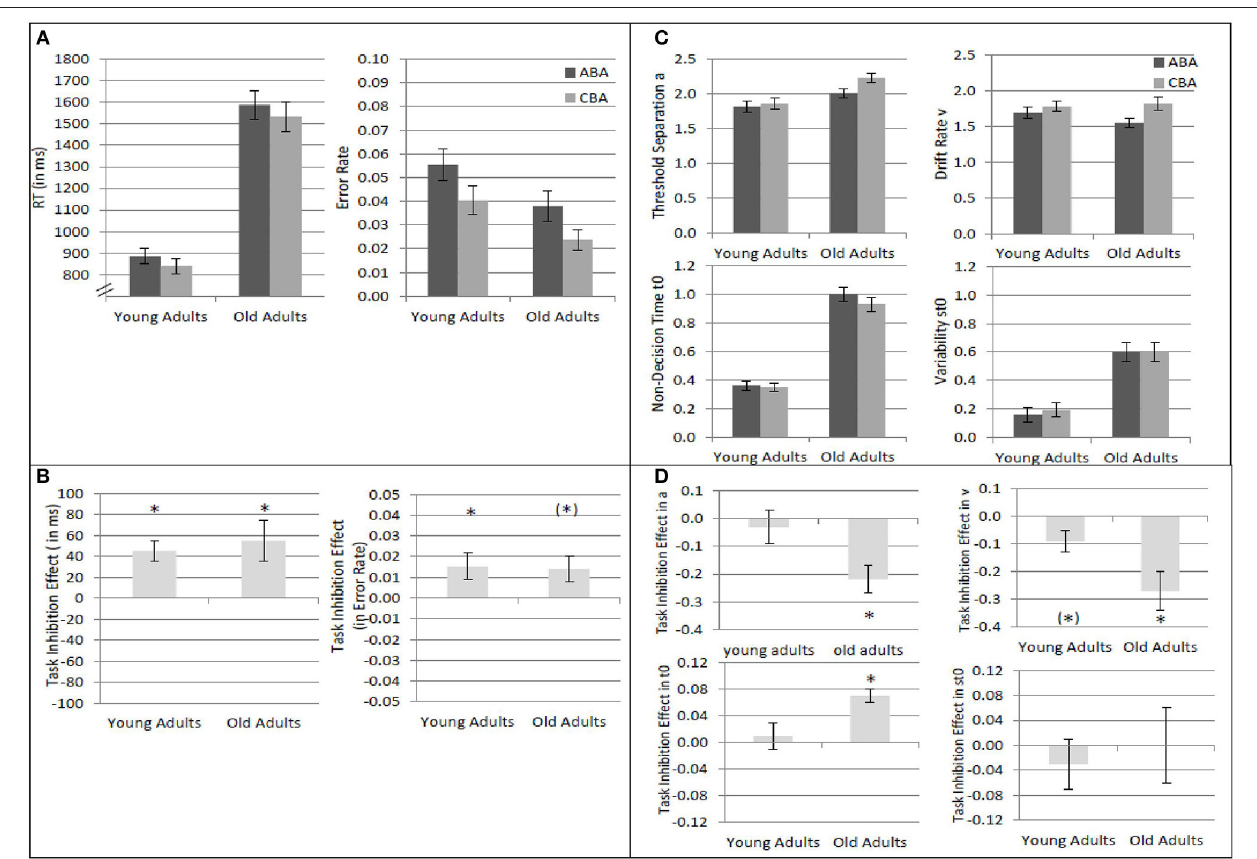
FIGURE 2 | Analysis of task inhibition (ABA vs. CBA task sequences) in young adults (18–26 years; N = 22) and older adults (64–79 years; N = 18). (A) Mean reaction times and mean error rates in ABA and CBA trials. (B) Mean task inhibition effect (ABA–CBA) in reaction times and error rates. (C) Diffusion model parameters threshold separation a , drift rate ν , non-decision time t 0 , and variability of non-decision time s t 0 , separately for ABA and CBA trials, and young and older adults. Units on the y-axis represent the untransformed values as obtained by the fast-dm software (Voss and Voss, 2007; diffusion coefficient = 1.0). The units represent amount of evidence for a ; evidence per time for ν ; time (in s) for t 0 and s t 0 . (D) Mean task inhibition effect (ABA–CBA) in diffusion model parameters. Error bars indicate 1 standard error of mean. * indicates significant task inhibition effect, i.e., p < 0.05 for the two-tailed t -test comparing ABA and CBA within each age group; (*) indicates p < 0.10 for the two-tailed t